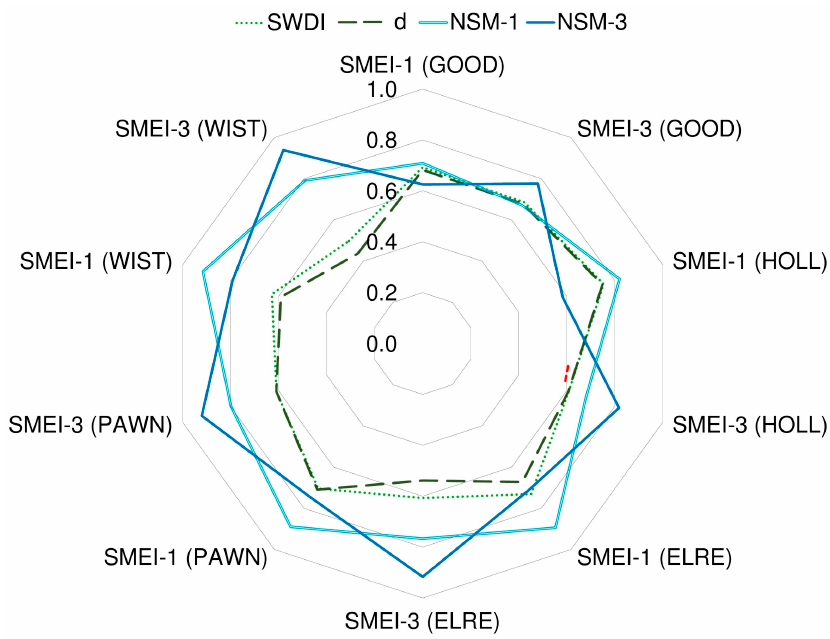
Figure 2. Radar plots of correlation coe ffi cients for new and existing soil moisture-based indices.